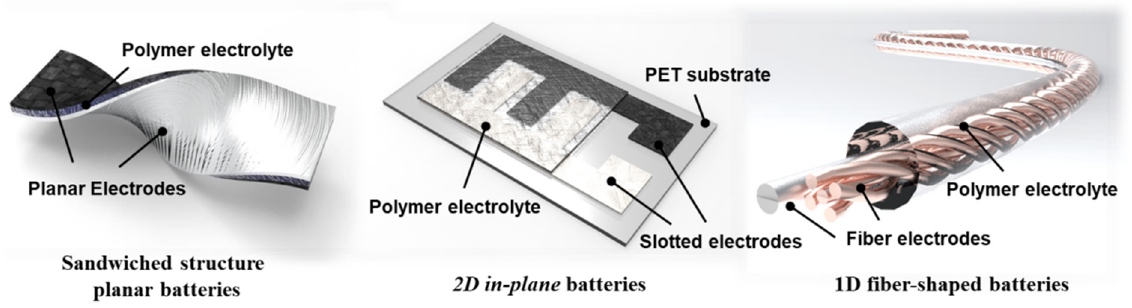
Figure 2. Diverse configurations of flexible batteries.